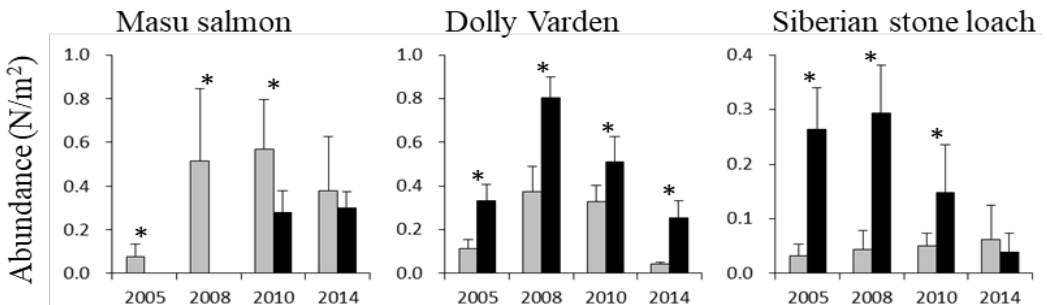
Figure 8. Temporal changes in the fish abundance (N / m 2 ) in the downstream (gray bar) and upstream (black bar) reaches of the dam pre- (2005 and 2008) and post-dam-removal (2010 and 2014). Asterisks above the bars indicate significant differences between the downstream and upstream reaches (* p < 0.05).